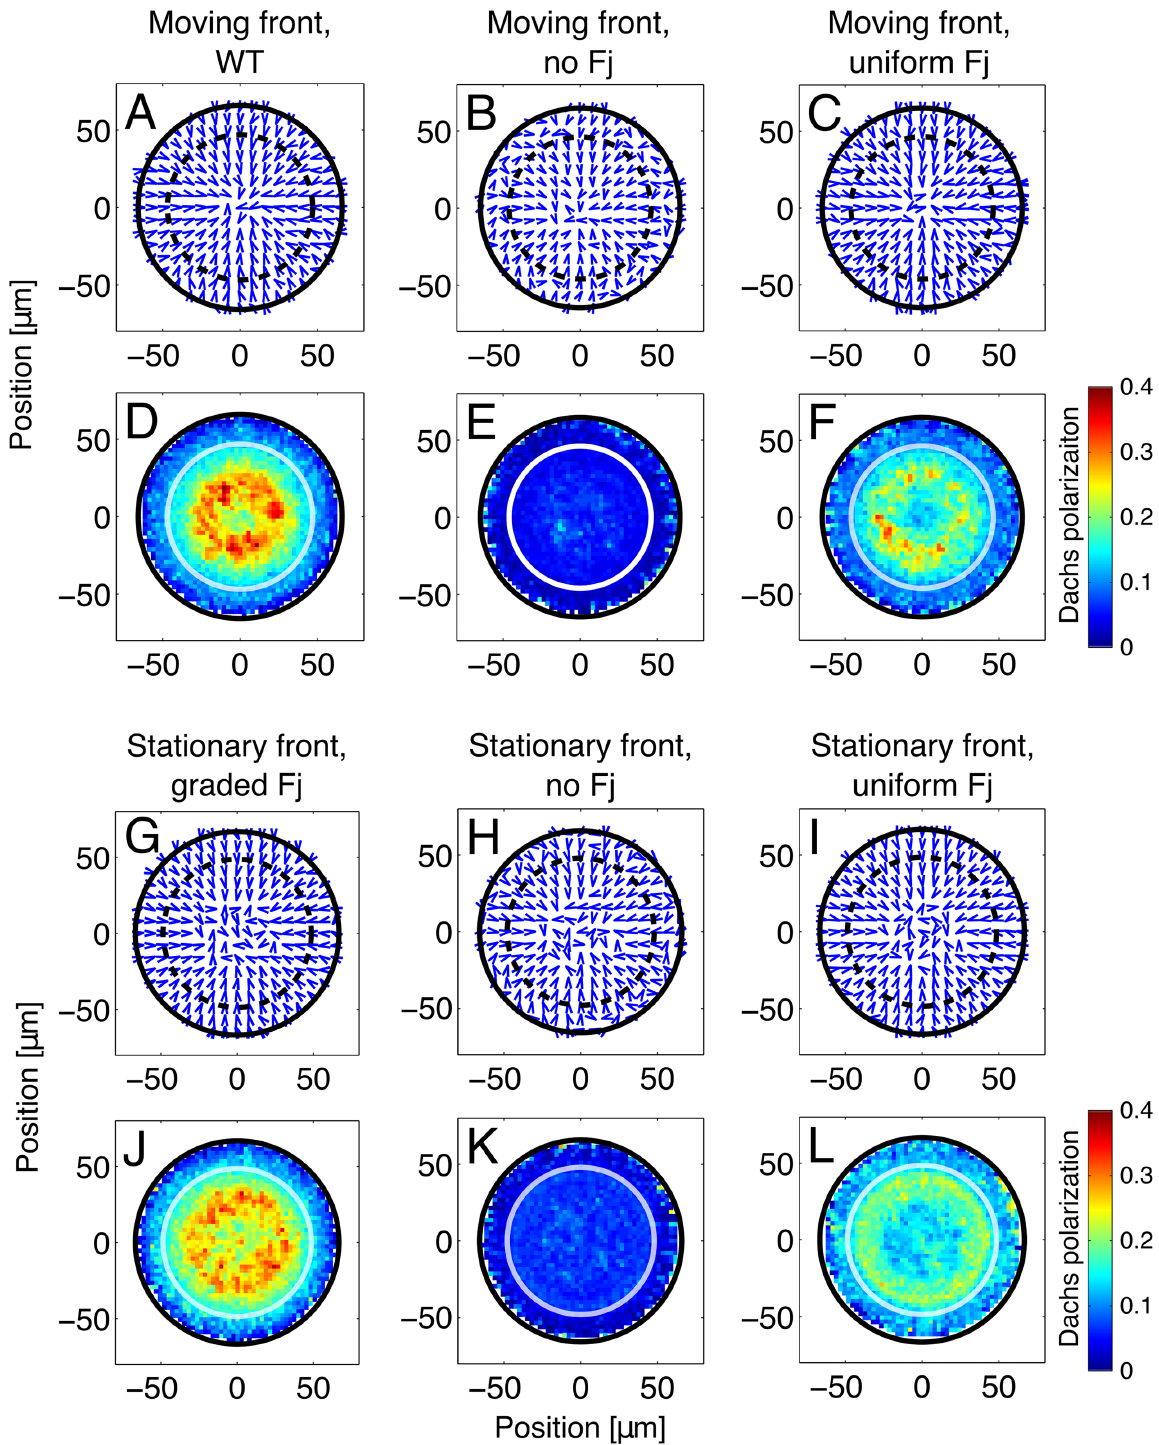
Fig 4. Dachs localization under different conditions of Fj and Ds expression. We show the direction(panels A-C, G-I) and magnitude (panels D-F, J-L) of Dachs localization at minute 2100 with a moving (A-F) and stationary (G-L) Ds front, and with wild-type (first column), absent (secondcolumn), and uniform (third column) Fj overexpression by roughly a factor of 10 times more than wild- type. Note that Dachs near the front is distally localizedin all cases, but this polarizationis stronger when Fj is present and stronger